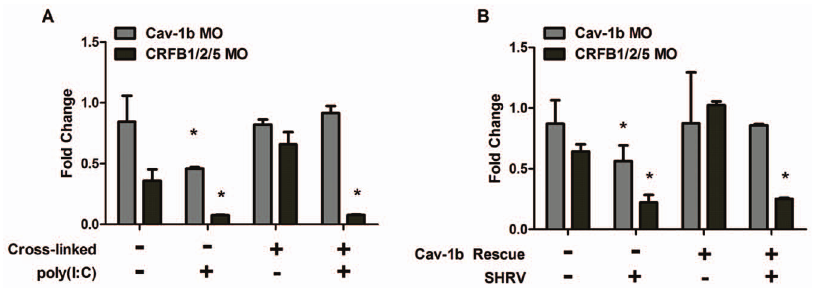
Figure 6. MxA expression is retained with rescue of Cav-1b depletion. ZFL cells were transfected and rescued as described in Methods. Shown is the fold difference in gene expression of MxA, an interferon stimulated gene. MxA transcript levels in Cav-1b depleted cells treated with crosslinking reagent (A) or rescued with cav-1b plasmid (B) show that rescuing caveolar disruption negates the depletion of caveolae which keeps CRFB1 molecules clustered under normal conditions. When Cav-1b is depleted and caveolae are not maintained with crosslinking reagent or cav-1b plasmid, minimal MxA expression is measured. The knockdown of CRFB1, CRFB2, and CRFB5 is the negative control; data indicate that there is low induction of MxA without IFN receptor subunits. When Cav-1b is depleted and CRFB1 is kept clustered, MxA expression remains at the same level as in the controls, demonstrating that the clustering of the receptor is essential for downstream signaling and that caveolin-1 plays a critical role in keeping the receptor clustered. Representative of 3 experiments; error bars indicate SEM (*, p , 0.05). These results indicate dampening of MxA transcript production between control MO and Cav-1b MO prior to rescue of caveolae domains, and no significant difference of MxA transcript levels between Control MO and Cav-1b MO after rescue of caveolae